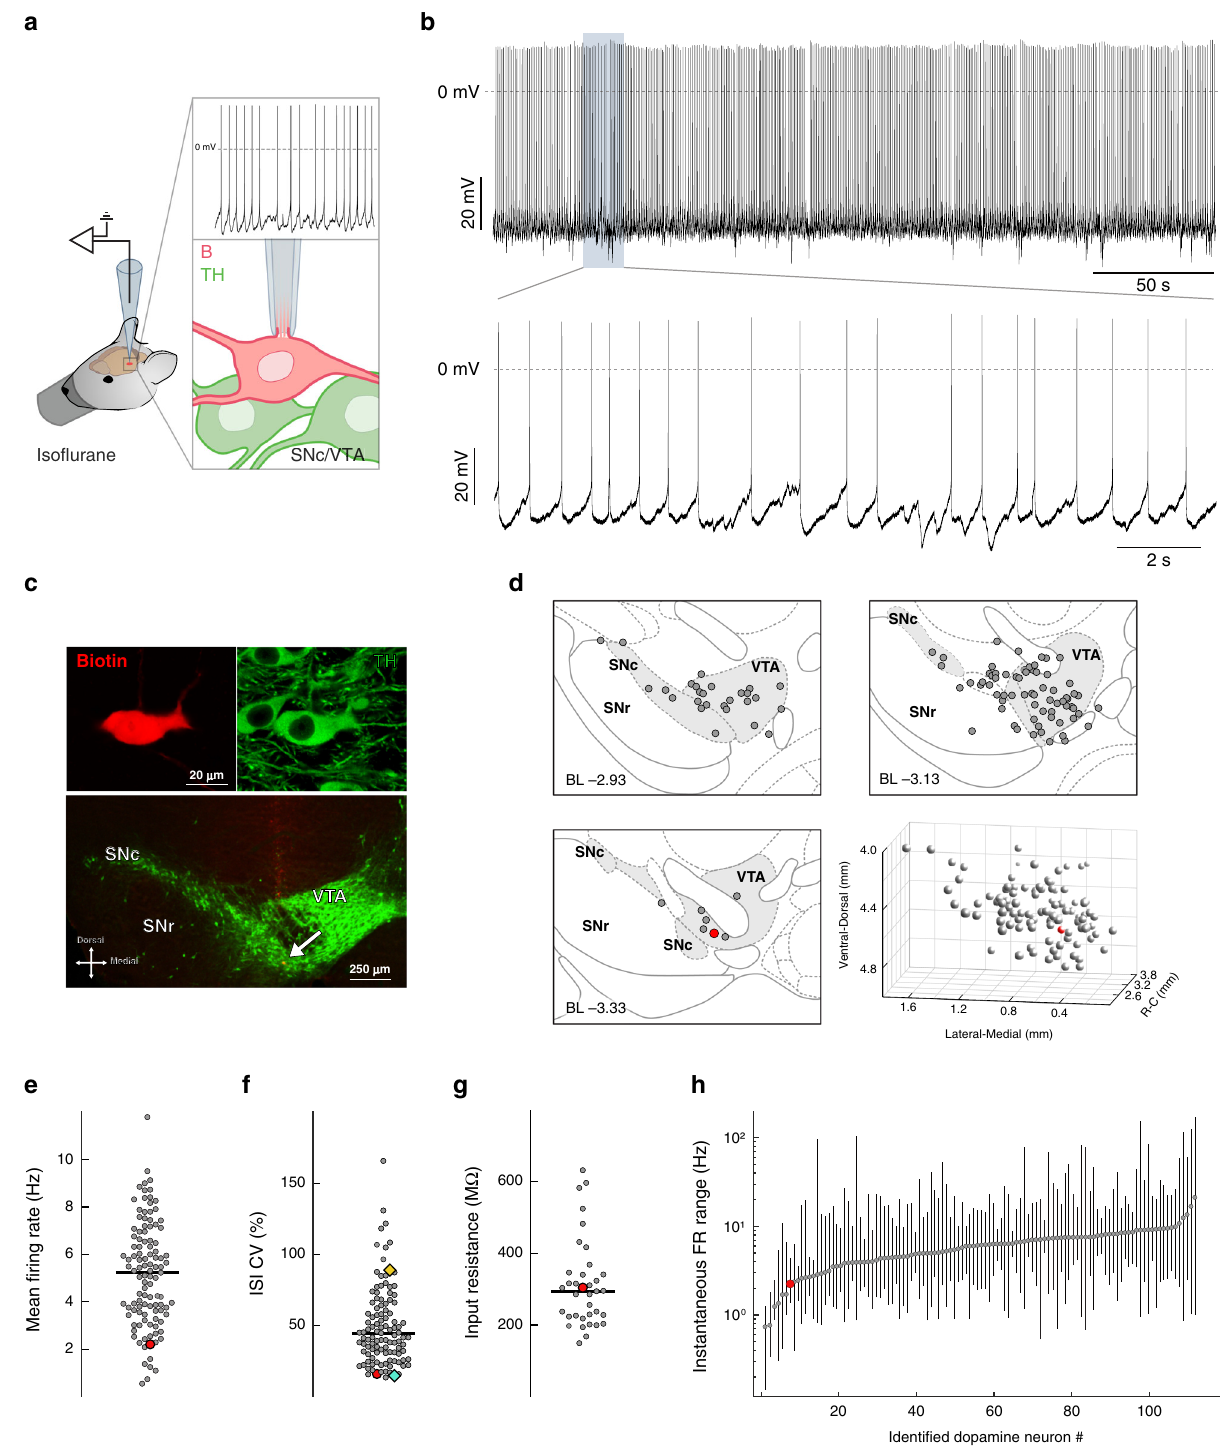
overshooting action potentials interspersed by resting periods where the membrane potential is hyperpolarized below the threshold for action potentials (Fig. 1b, bottom trace). Post-hoc immunocytochemistry identi fi ed this cell as a dopamine neuron localized in the ventral-caudal VTA (Fig. 1c, bottom image; and 1d, red circle). Figure 1e, f show the mean fi ring rates and CVs of spontaneous fi ring activity from 110 dopamine neurons, respectively (mean fi ring rates median (interquartile range, IQR) = 5.25 (3.56 – 6.76);